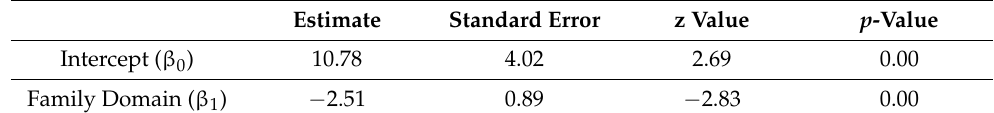
Table 7. Estimates of the fitted model parameters.